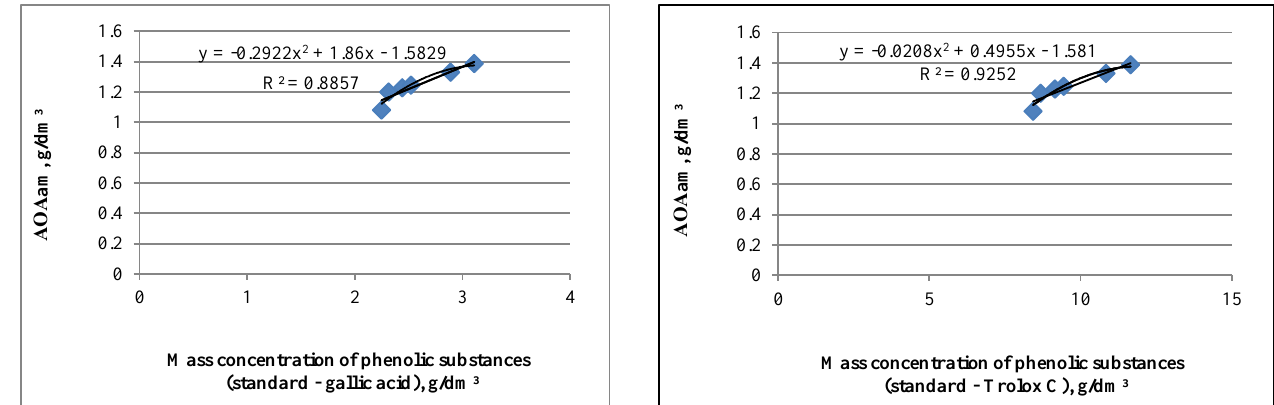
Figure 4. Correlation of the AOA am index of red table wine materials and the mass concentration of phenolic substances (standard — gallic acid and standard — Trolox-C).